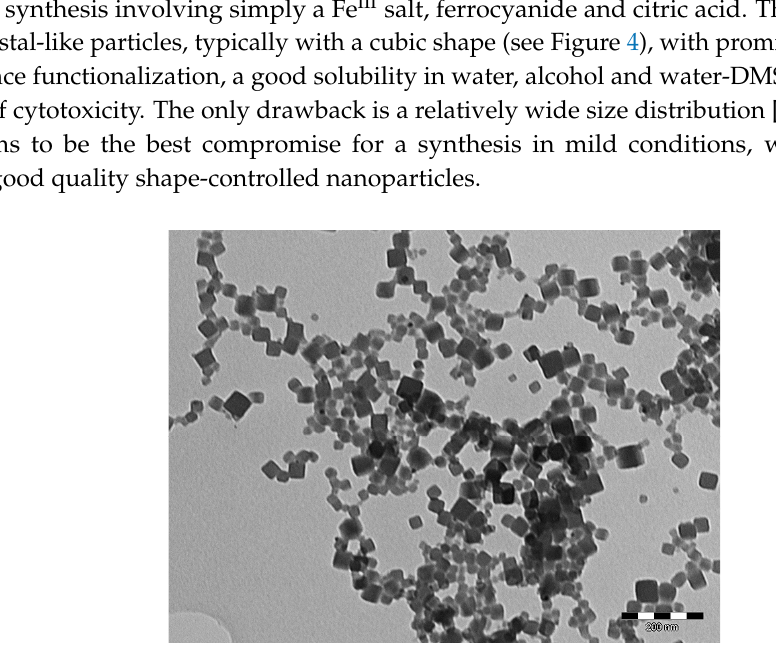
Figure 4. TEM micrograph of citrate-stabilized PBnp, prepared following Ref. [10] (authors’ unpublished